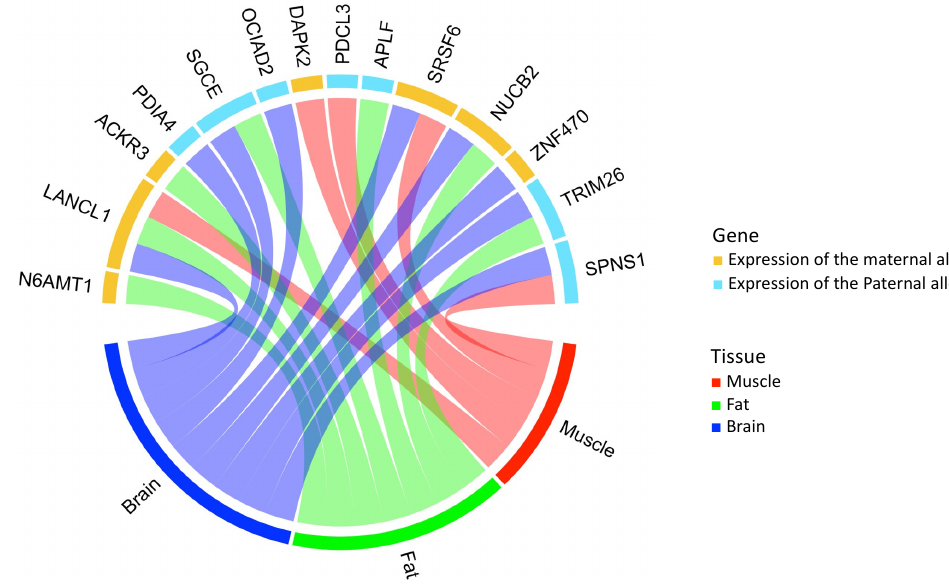
Figure 2. Tissue-specific monoallelic expression of 14 genes in muscle, fat, and brain tissues. The upper and lower hemispheres of a circle plot indicate genes and tissues, respectively. Yellow and light blue indicate the parental origin of the expressed alleles. The MAE status for each tissue is represented by red, green, and blue. As shown in Table 1, we compared the identified genes with databases that provide the gene status of autosomal monoallelic expression or imprinting in multiple species,